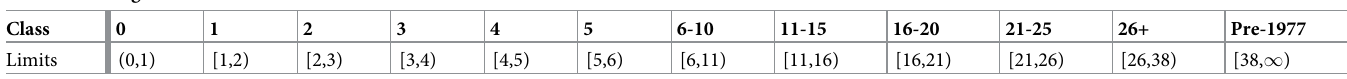
Table 2. Firm age class